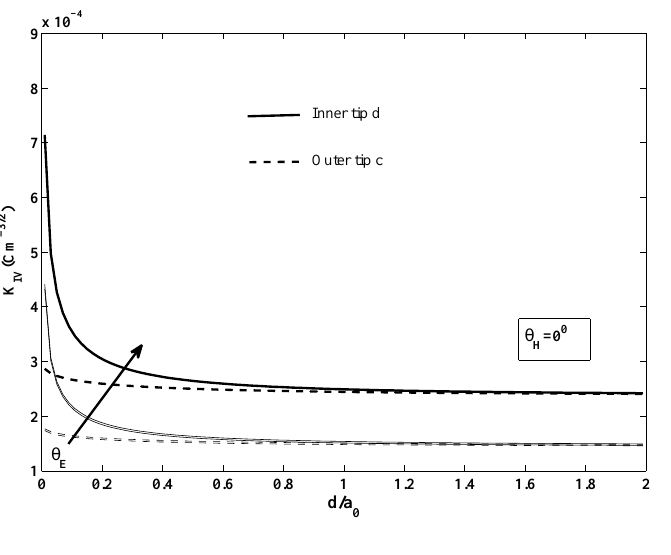
Fig. 5 EDIF versus inter-crack distance for different electric poling with fixed magnetic